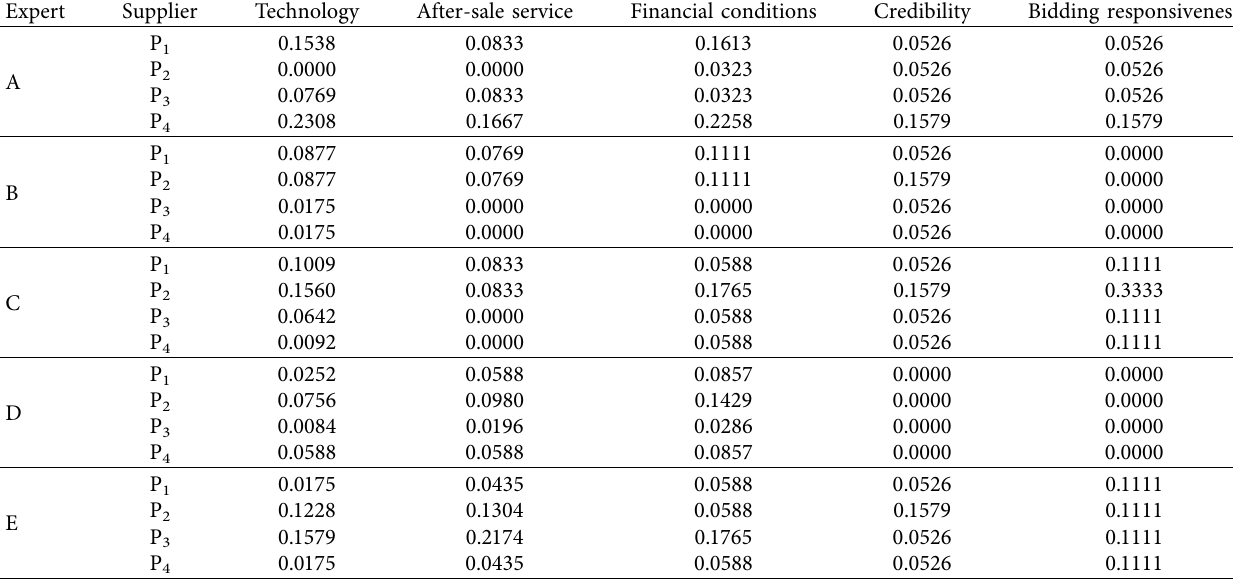
Table 3: Normalization of individual evaluation